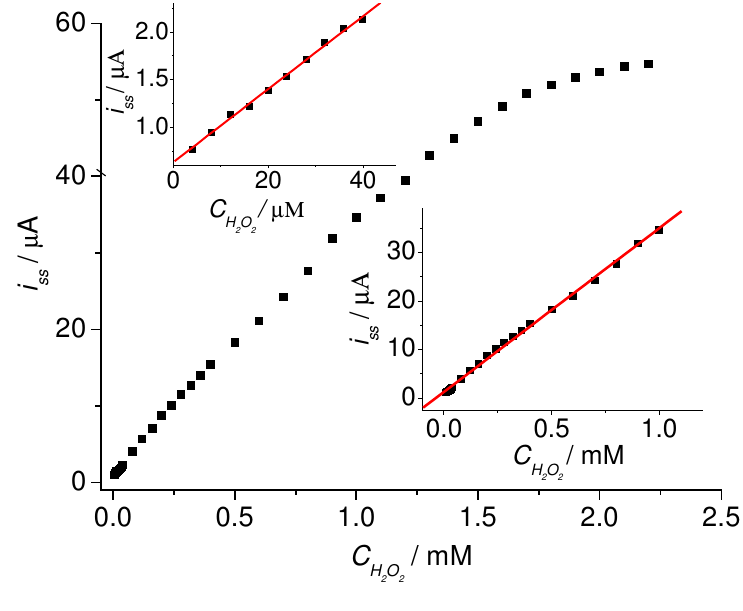
Figure 7 . Calibration curve of HRP-Au-SPCE for successive addition of H 2 O 2 in 0.1 M pH 7.0 PBS. Insets: linear calibration